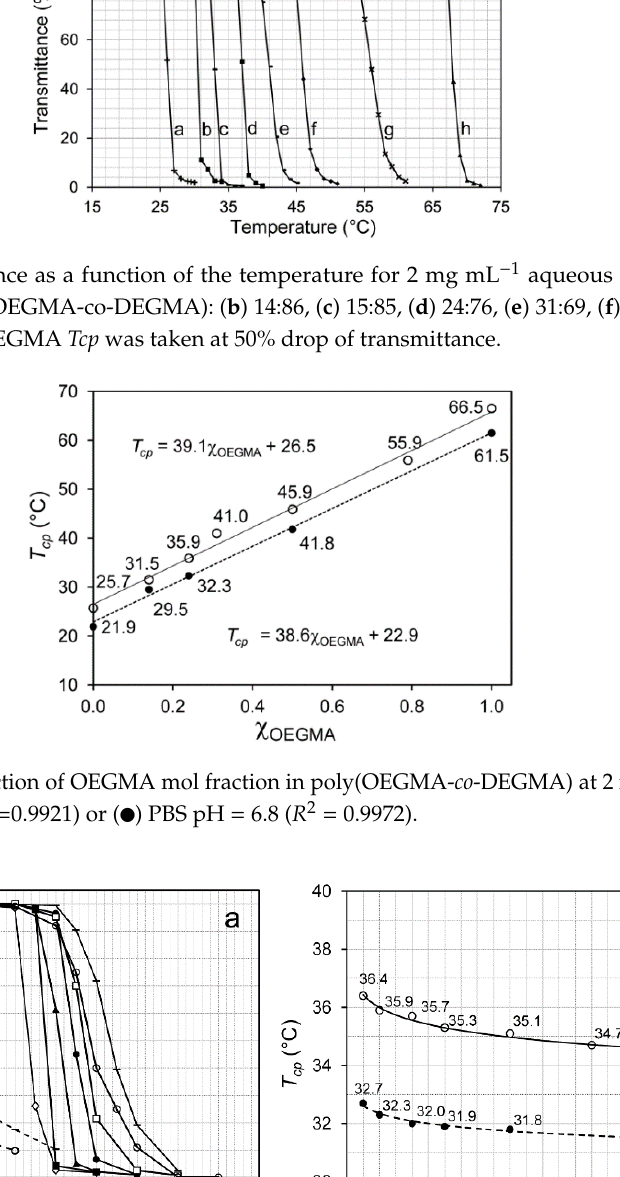
) 2, and ( - ) 1 mg mL − 1 (cid:35) ) distilled water or (cid:35)